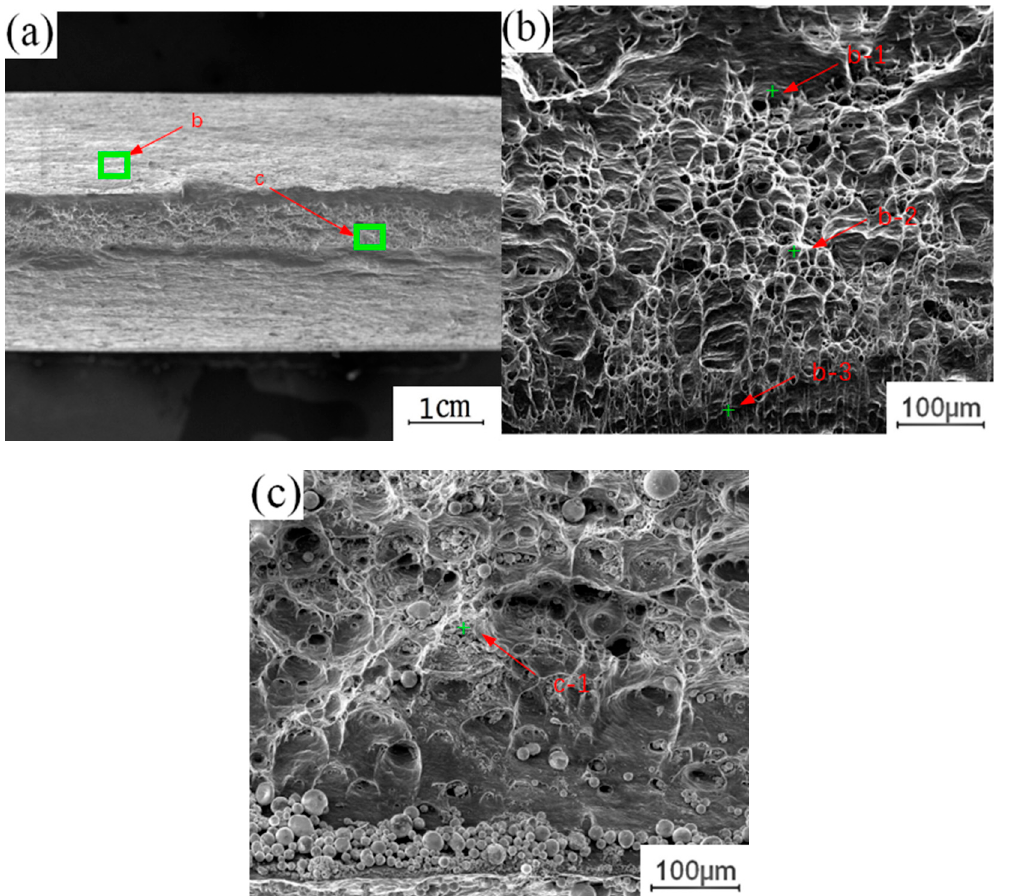
Figure 12. Fracture morphology of the fracture specimen along the Cu-Al joining Interface: ( a ) Macroscopic morphology; ( b ) b morphology; ( c ) c morphology.